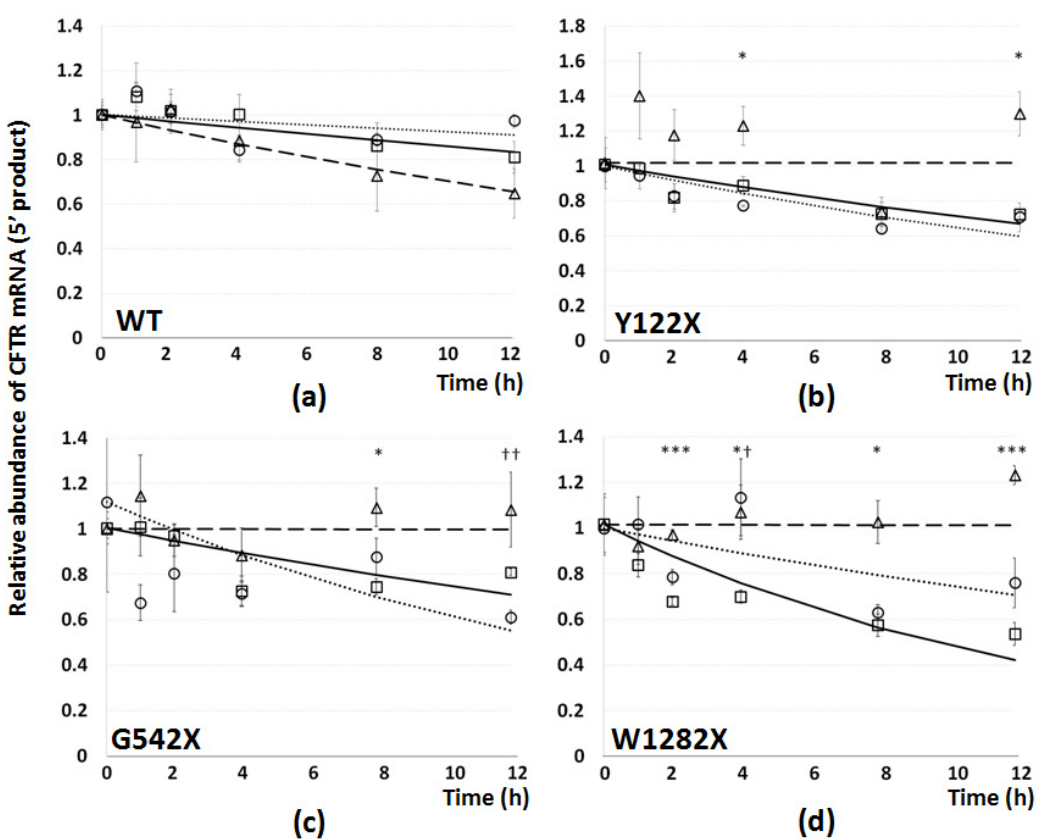
Figure 6. Effect of PTC mutations and of treatments on CFTR mRNA stability: 5 (cid:48) end. Degradation curves for CFTR mRNA were generated by RT-qPCR using the 5 (cid:48) CFTR primer pair following transcriptional shutdown using Actinomycin-D, exactly as for the 3 (cid:48) primer pair (Figure 5), in 16HBE cells expressing ( a ) wt-, ( b ) Y122X-, ( c ) G542X-, or ( d ) W1282X-CFTR. Relative abundance of CFTR mRNA is represented on the y-axis, and time (h) following Actinomycin-D administration on the x axis. Cells were either untreated (squares and solid regression curves) or treated with G418 (500 µ g/mL for 24 h: circles and dotted line) or SMG1i (1 mM, 24 h: triangles and dashed line). Observed data values are represented by shapes ( n = 3 ± SEM), and exponential degradation curves generated by best fit analysis overlaid. Significant differences between untreated cells and SMG1i (asterisks) and G418 (crosses) treatments are shown ( p < 0.05, 0.01, or 0.001).